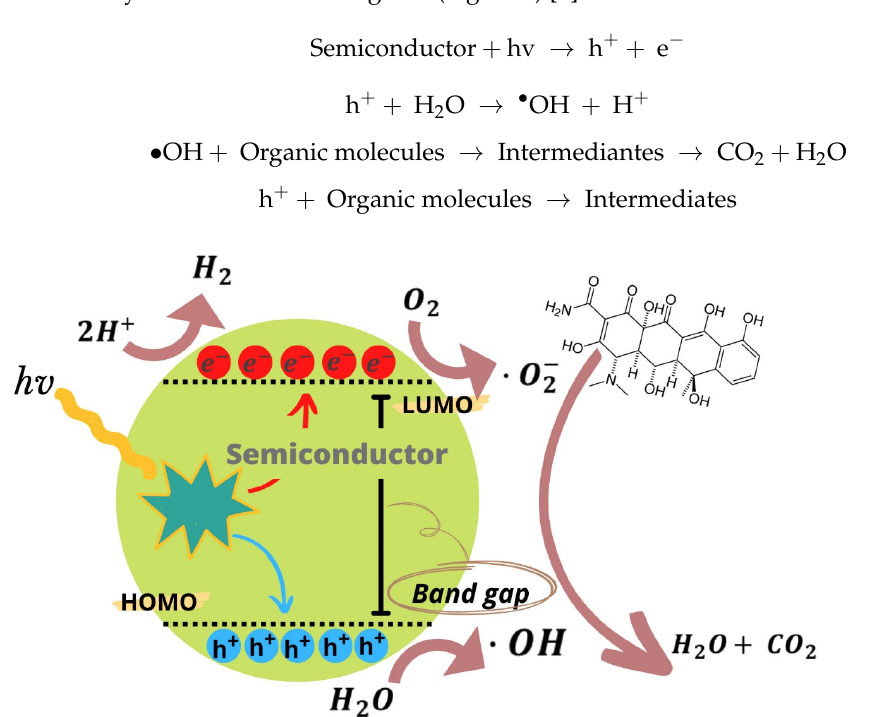
Figure 1. Heterogeneous photocatalytic process to degrade organic pollutants in water and green H 2 production through the water splitting reaction.